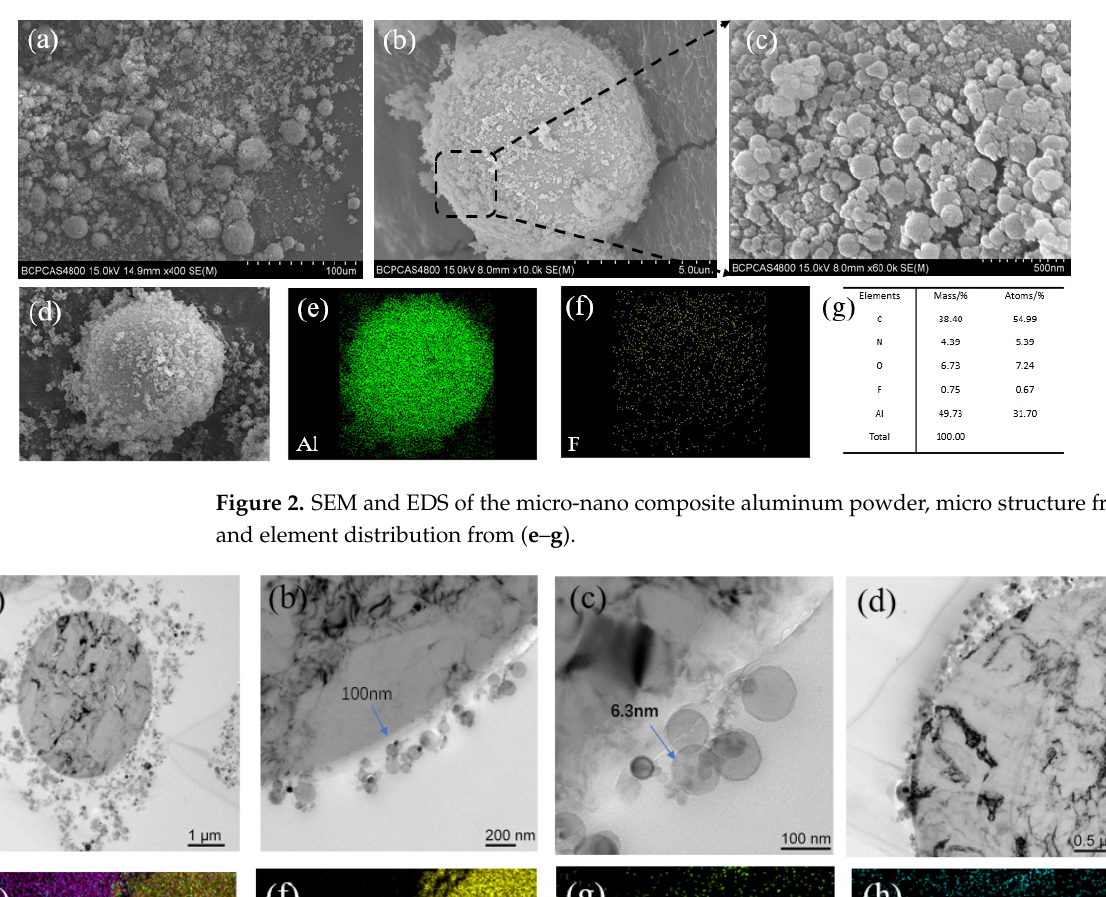
Figure 2. SEM and EDS of the micro-nano composite aluminum powder, micro structure from ( a – d ), and element distribution from ( e – g ).